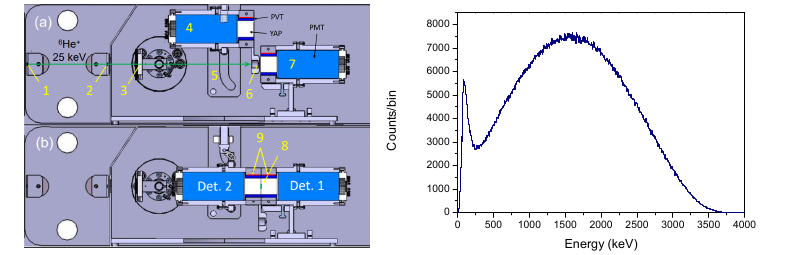
Figure 1. Left panel: sectional view of the experimental setup during beam implantation (a) and data taking (b). The labels on panel (a) are: 1 and 2– the two Ø6 mm collimators in the first section of the chamber; 3– a movable Si detector; 4 and 5– the moving detector and its mechanical guide; 6– the third Ø4 mm collimator; 7– the fixed detector. The green arrow indicates the 6 He + beam. On panel (b), label 8 indicates the implantation region and 9 the two 241 Am calibration sources [3]. Right panel: experimental β -energy spectrum for one run of two hours